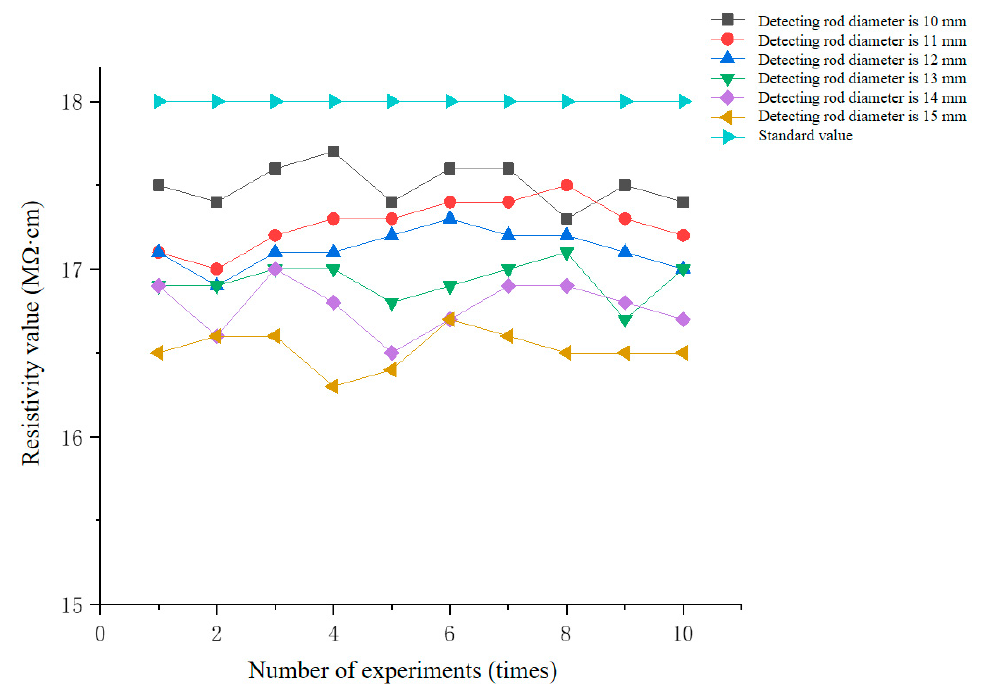
Figure 17. Experimental plot of distilled water with equal electrode diameter and different detecting rod diameter.